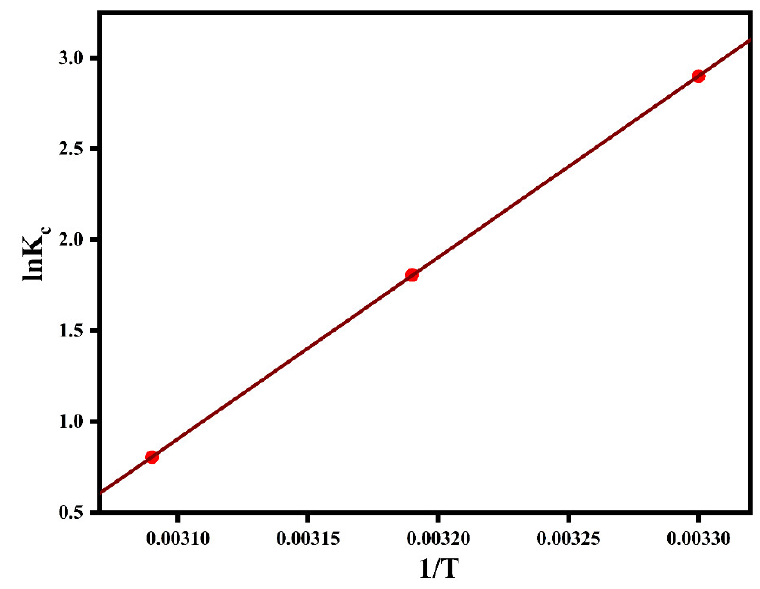
Figure 10. The Van’t Hoff plot for CR dye on agar/zeolite/CMC/PVA biomembrane. Table 5. Thermodynamic parameters for adsorbent agar/zeolite/CMC/PVA biomembrane. ΔG(kj/moL) ΔH(kj/moL) ΔS (j/moL K) 303 K 313 K 323 K −9.129 −3.16 −0.49 −83.6 −257